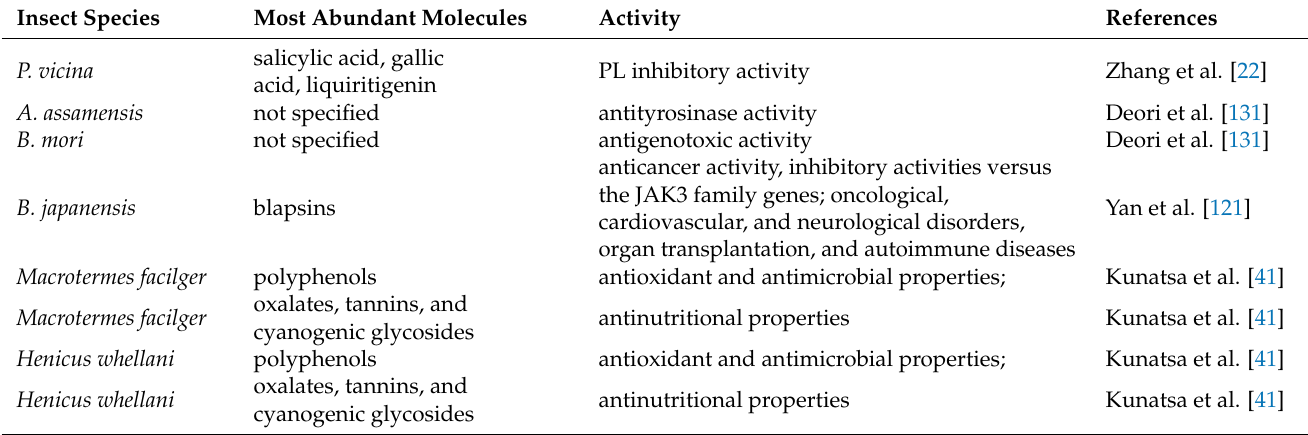
Table 4. Biological activity of insect